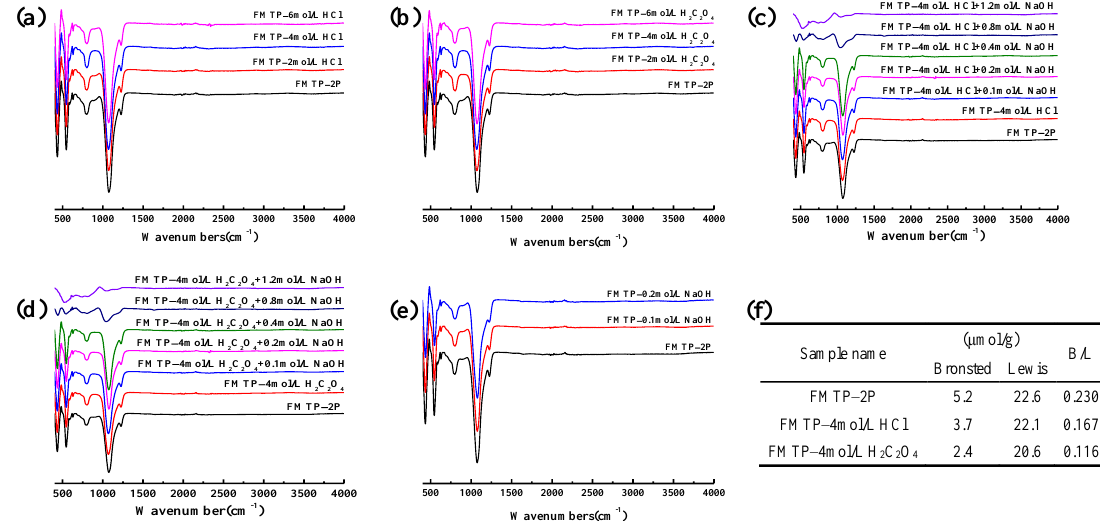
Figure 2. ( a ) FT-IR diagrams of spent catalyst samples before and after HCl treatment; FT-IR diagrams of spent catalyst samples before and after ( b ) H 2 C 2 O 4 treatment; ( c ) alkali combined treatment of 4 mol/L HCl-treated waste catalyst; ( d ) alkali-combined treatment of 4 mol/L H 2 C 2 O 4 -treated waste catalyst; ( e ) alkali treatment; ( f ) Brønsted acid (B-acid) and Lewis acid (L-acid) contents of waste catalysts treated with different acids.